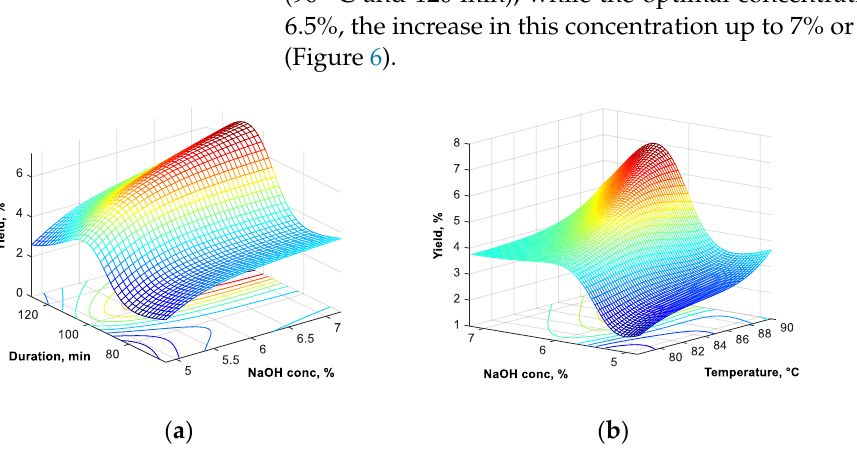
Figure 6. Yield variation for 90 °C temperature ( a ), 120 min working time ( b ) and 6.5% NaOH concentration ( c ).